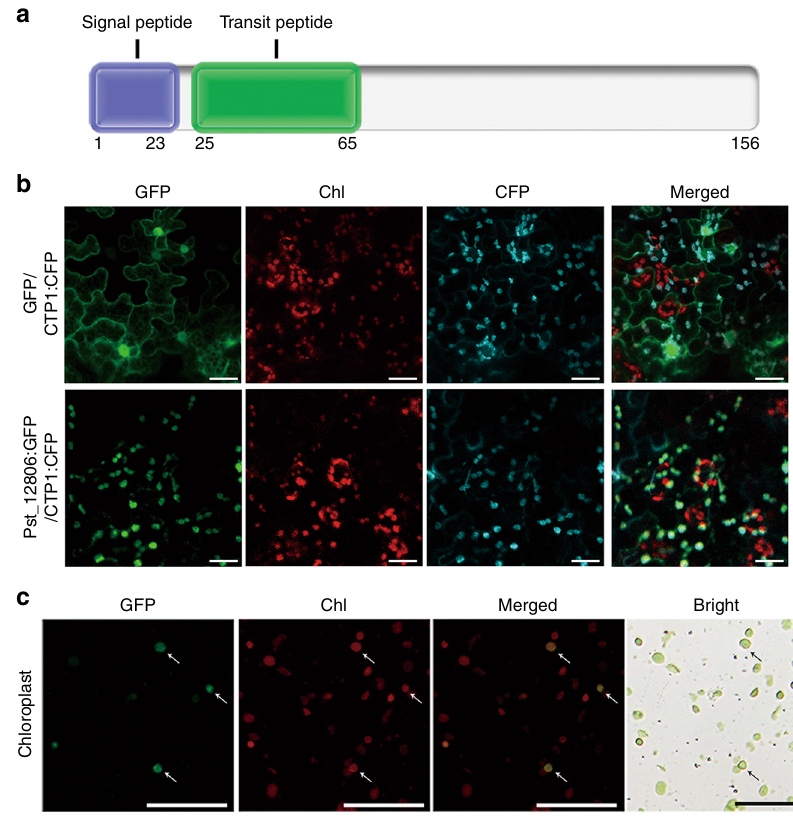
Fig. 1 Pst_12806 accumulates in plant chloroplasts. a Pst_12806 protein is predicted to have a signal peptide (1 – 23 aa) and a transit peptide (25 – 65 aa) by the SignalP 4.1 and LOCALIZER program. b Leaf tissues of N . benthamiana transiently co-expressing the Pst_12806 Δ SP :GFP and CTP1:CFP or GFP alone and CTP1:CFP were examined by epi fl uorescence microscopy. Chl, chlorophyll. Bar = 50 μ m. c Chloroplasts isolated from N . benthamiana leaves transiently expressing Pst_12806 Δ SP :GFP fusion were examined by epi fl uorescence and bright fi eld (BR) microscopy. The supernatant containing cytoplasm residues separated from chloroplast precipitates were examined as the control. Arrows point to chloroplasts. Bar = 50 μ